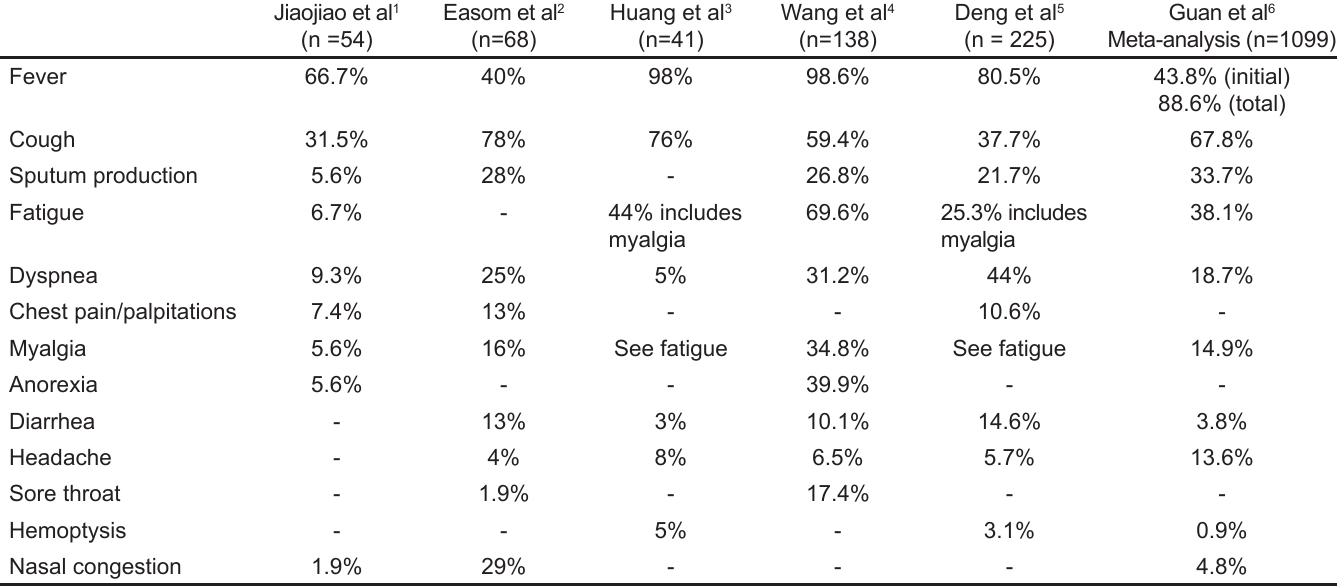
Table 2. Literature review of coronavirus 19 symptom